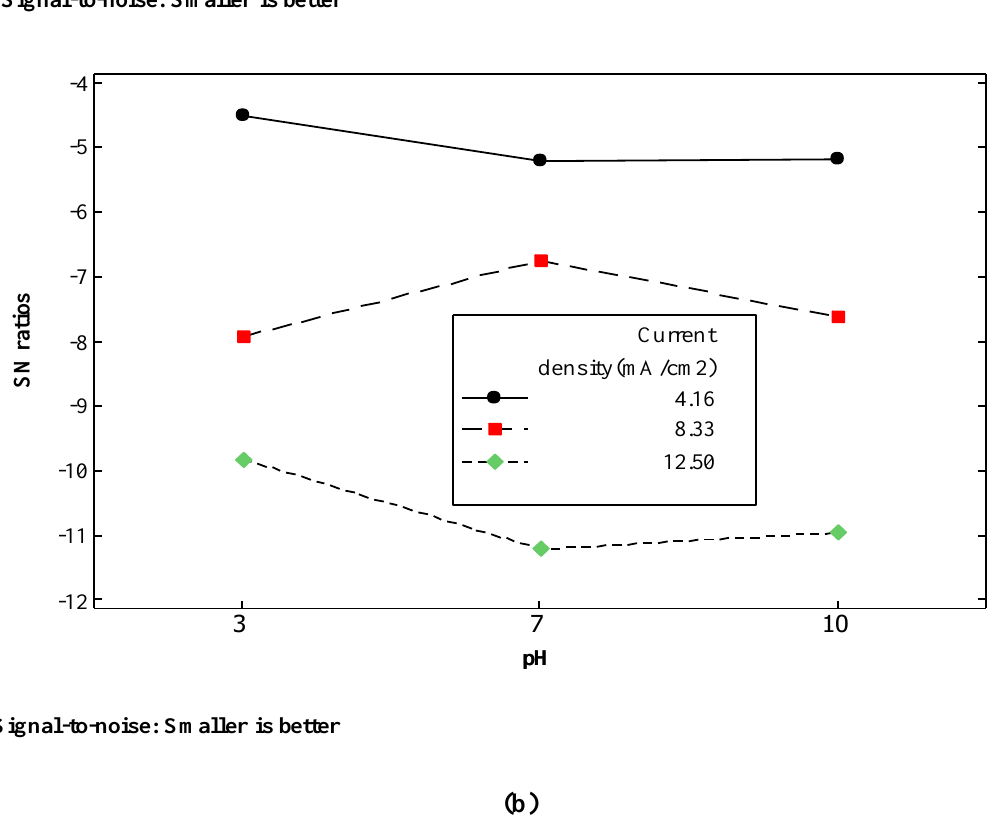
Fig. 3. Interactions plot for the responses of: (a) Cr +6 removal efficiency (%) and (b) operating costs (US$/m 3 ) in Taguchi